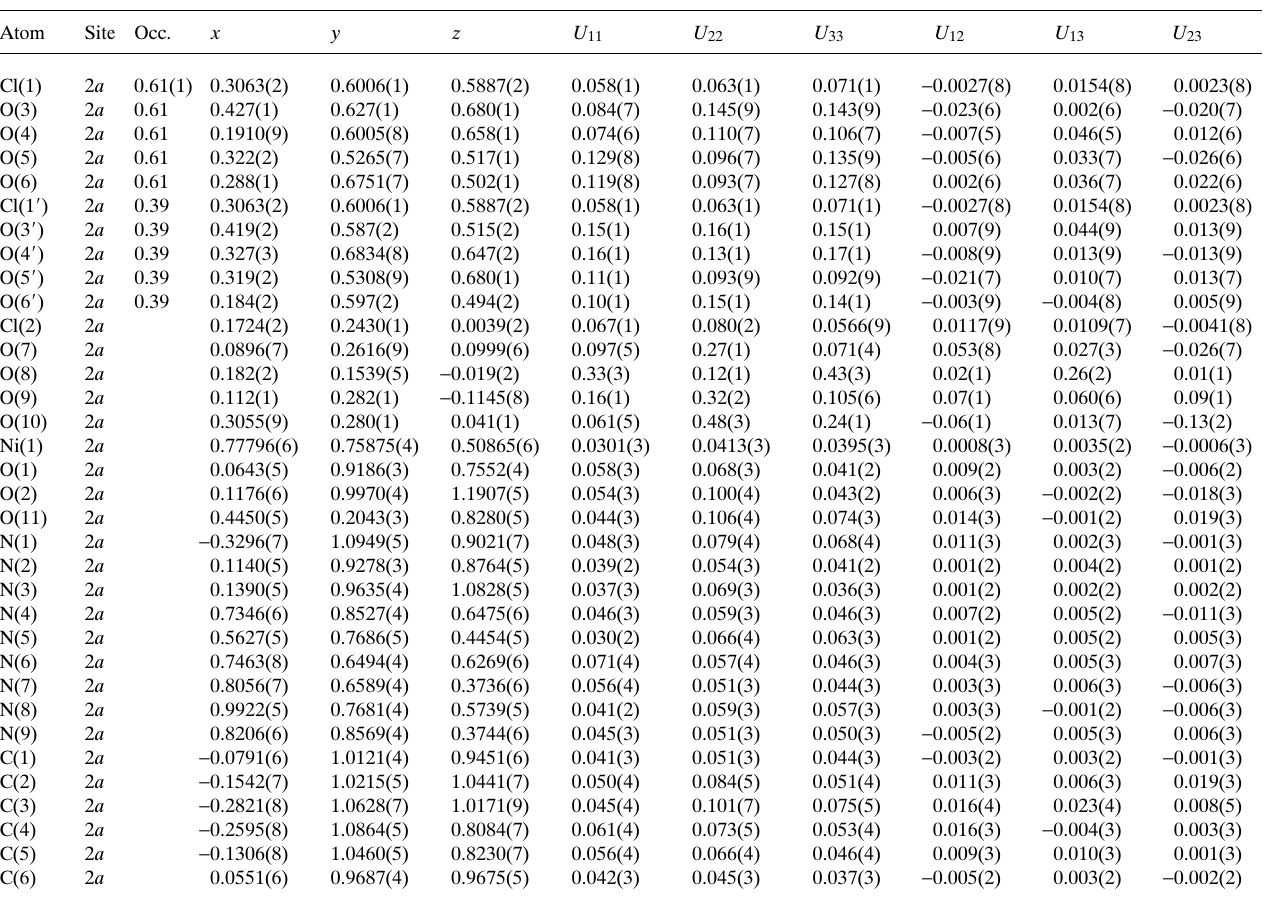
Table 3. Atomic coordinates and displacement parameters (in Å 2 ) .